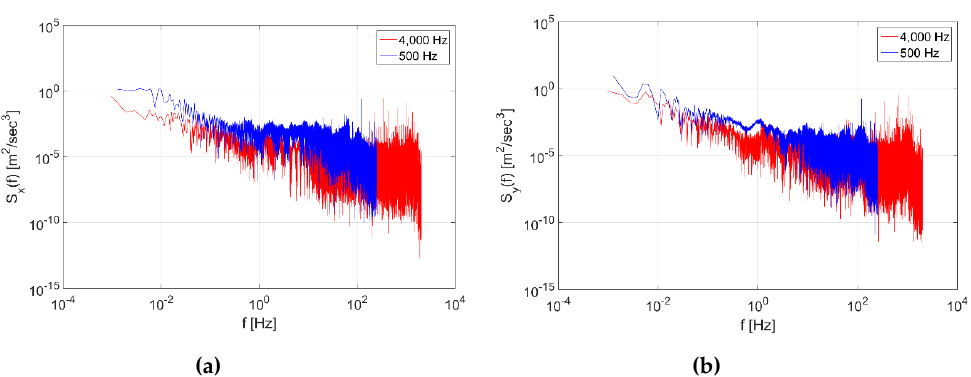
Figure 8. Power Spectral Density (PSD) of Korea Train Express (KTX) Data in the ( a ) longitudinal direction and ( b ) transverse